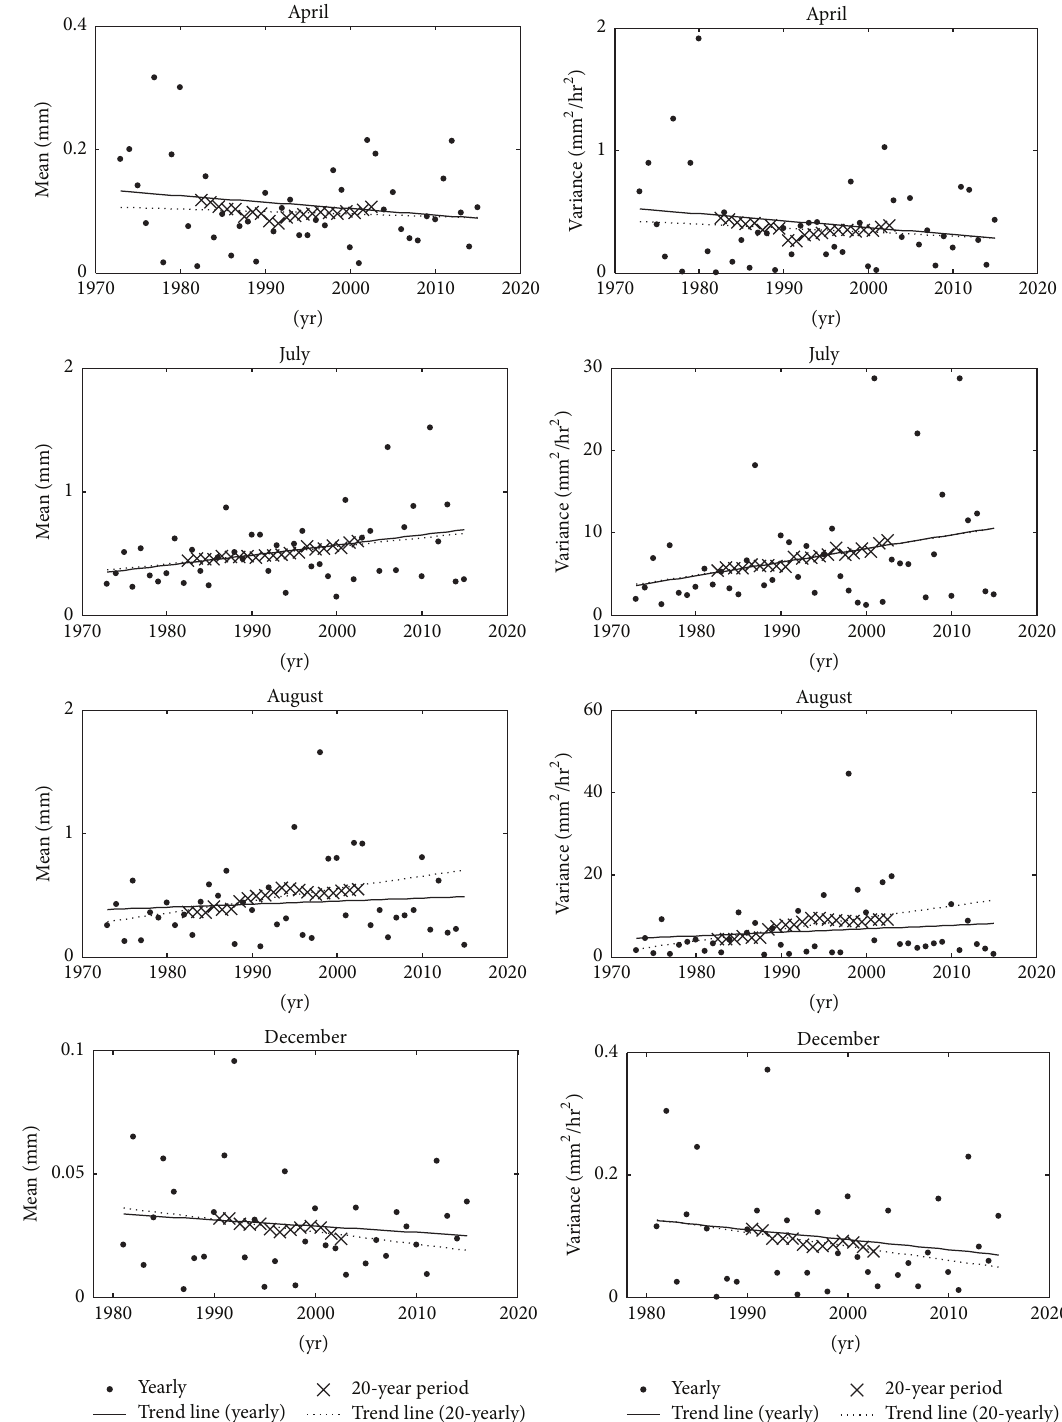
Figure 3: Temporal variation of yearly (dots) and 20-yearly (crosses) 1-hour precipitation mean and variance observed in Seoul. Linear trend lines of yearly (solid line) and 20-yearly (dotted line) 1-hour precipitation mean and variance are shown